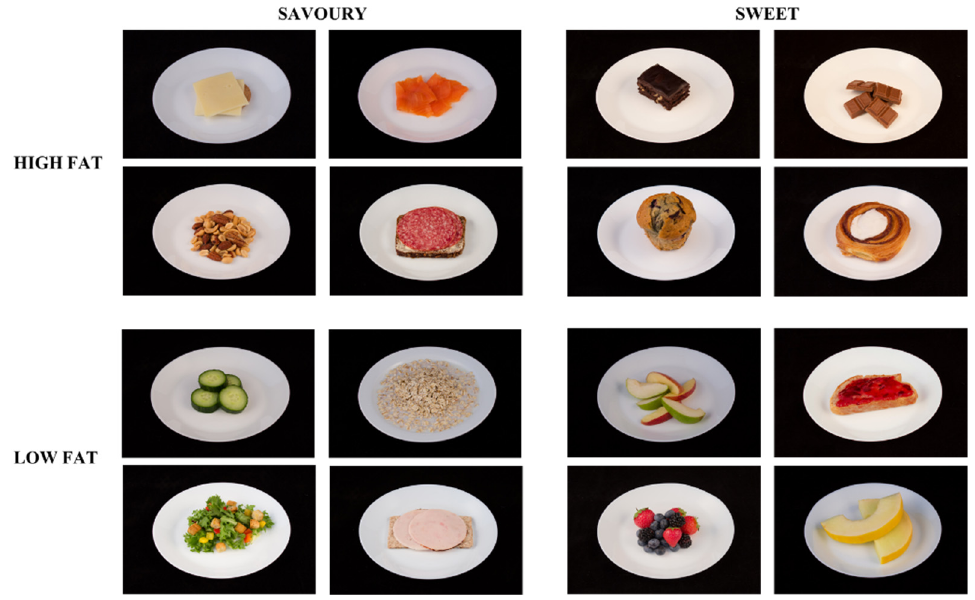
Figure 2. Food images included in the Leeds Food Preference Questionnaire. Foods differed according to sweet and savoury taste and fat content, resulting in four combined food categories.